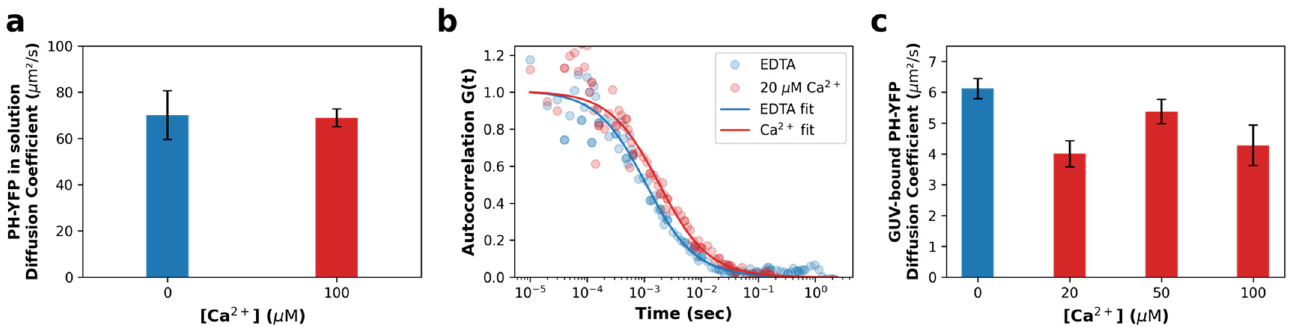
Figure 2. PH-YFP is unable to sequester lipids from Ca 2+ -induced PI(4,5)P 2 clusters. ( a ) Diffusion coefficients obtained for PH-YFP in solution, in the presence (red) and absence (blue) of Ca 2+ . ( b ) Representative FCS autocorrelation curves of PH-YFP in POPC:PI(4,5)P 2 (95:5 molar ratio) GUVs, in the presence and absence of Ca 2+ . ( c ) Diffusion coefficients obtained for PH-YFP in POPC:PI(4,5)P 2 (95:5 molar ratio) GUVs, in the presence and absence of Ca 2+ . Values represent means ± standard errors. Values from solution measurements for each condition are averages of five independent samples. Values from GUV measurements for each condition are averages of at least five different GUVs ( N 0 µ M Ca 2 + = 10, N 20 µ M Ca 2 + = 8, N 50 µ M Ca 2 + = 5, N 100 µ M Ca 2 + =